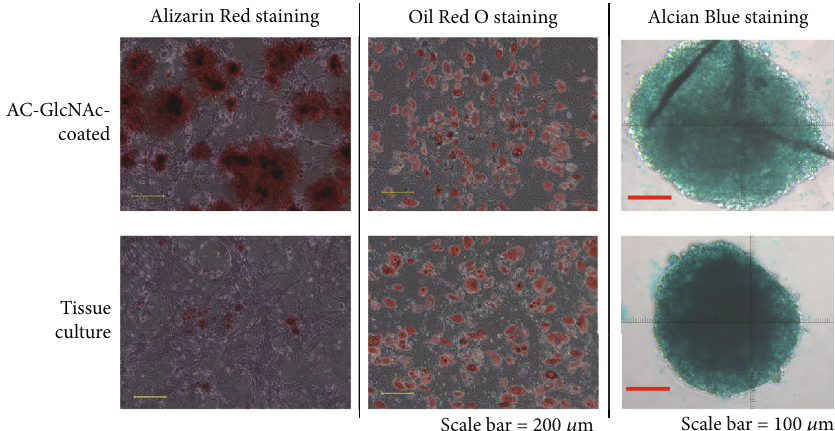
Figure 7: Osteogenic, adipogenic, and chondrogenic di ff erentiation is increased by selection of cells adhering to AC-GlcNAc-coated